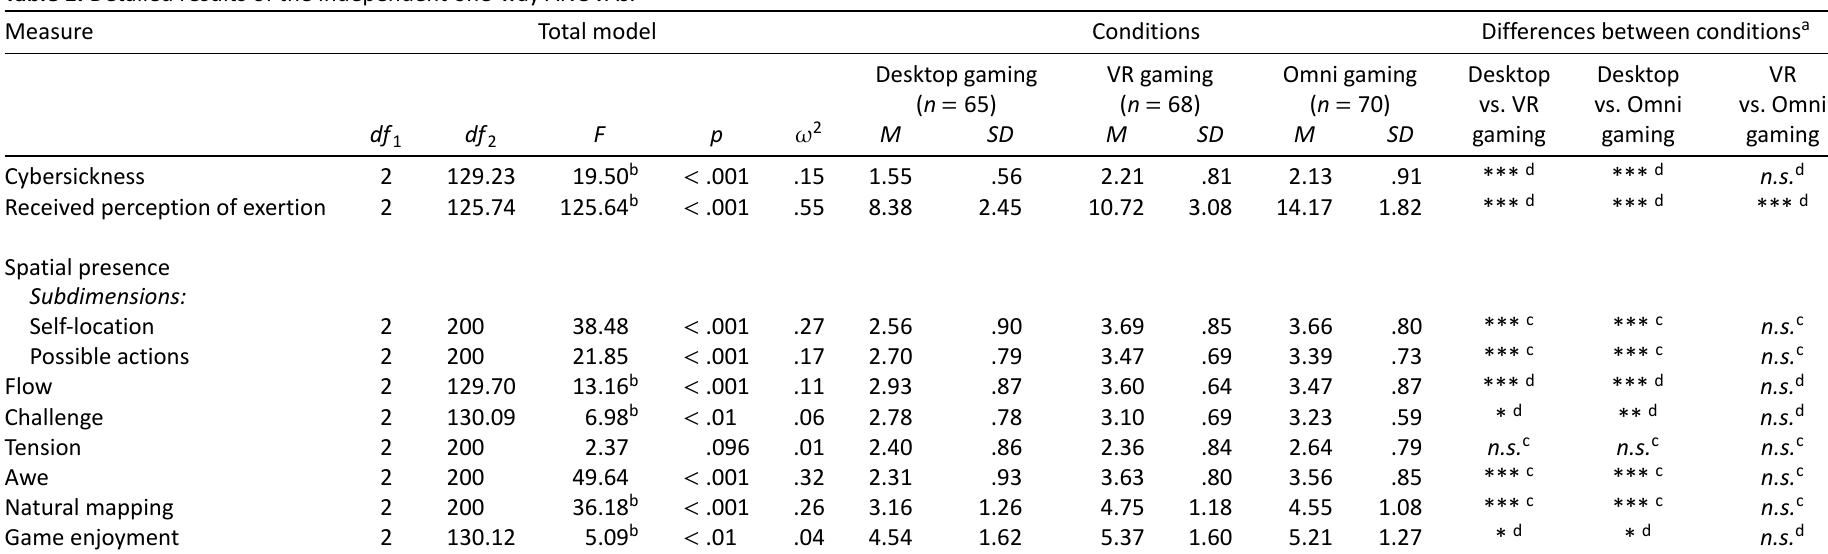
Table 1. Detailed results of the independent one-way ANOVAs.